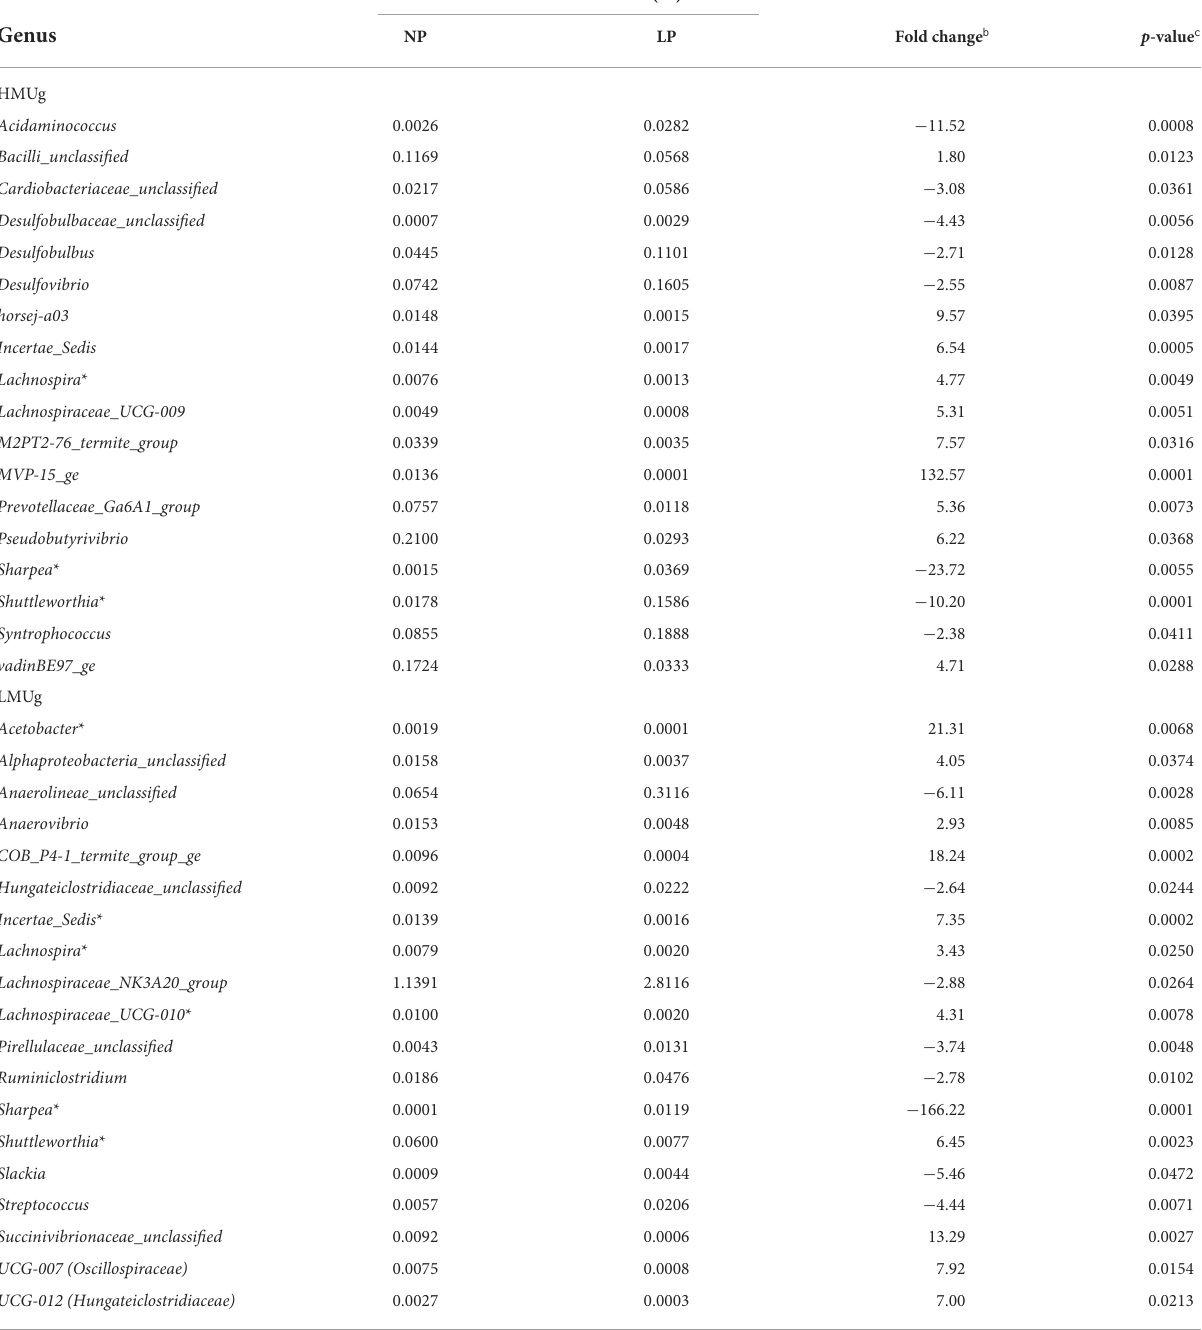
TABLE 2 Significantly differentially abundant genera (DAG) in the rumen comparing normal crude protein (NP) and low crude protein (LP) diet offered to HMUg and LMUg